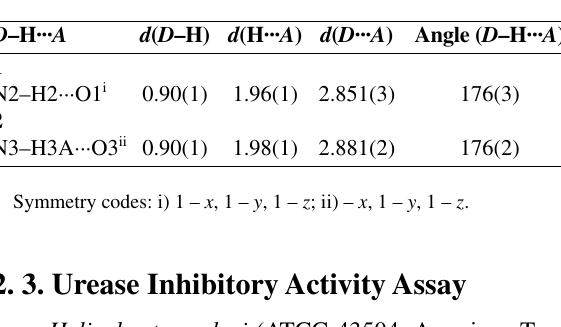
Table 2. Hydrogen bond distances (Å) and bond angles (°) for the